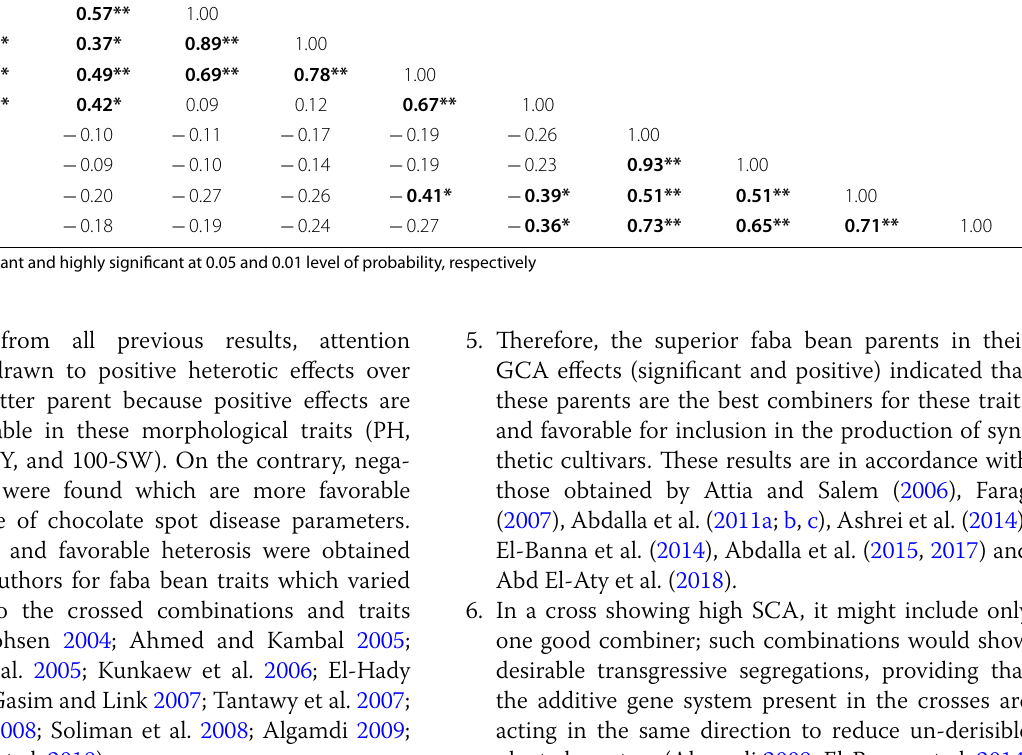
* and ** indicate significant and highly significant at 0.05 and 0.01 level of probability, respectively